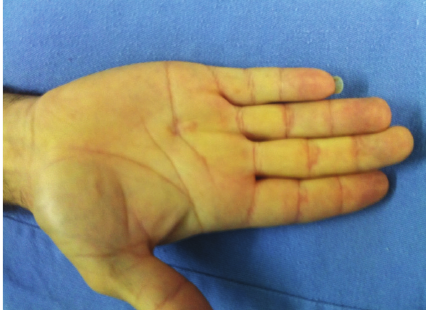
Figure 12: Dupuytren’s disease involving the fourth ray of the right hand. The patient had good mobility after percutaneous